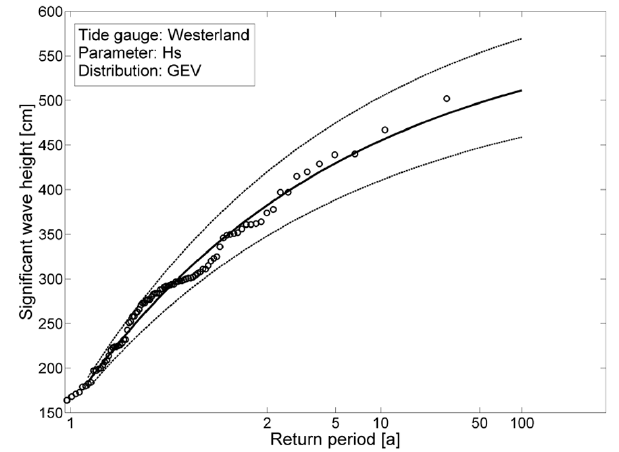
Fig. 5. Scatter plots for the parameter pairs ( F,H s ) (left) and ( S,H s ) (right). Fig. 6. Marginal distribution for the parameter